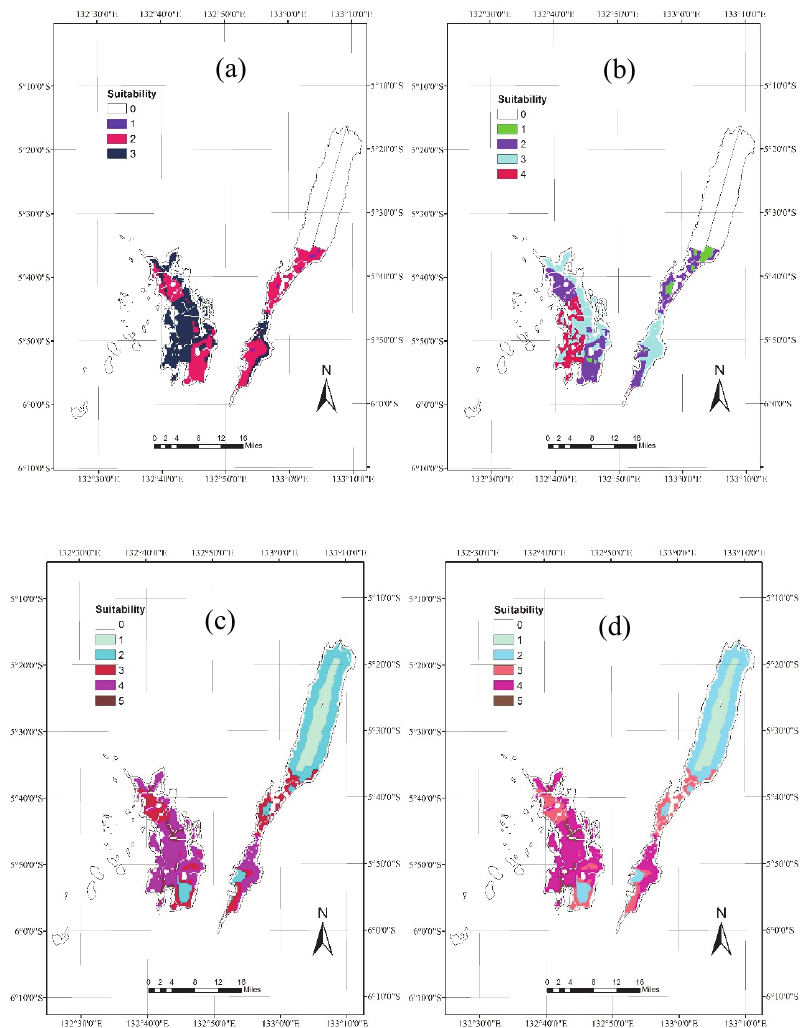
Fig. 8. Sensitivity test: (a) all criterion equal; (b) number of seaweed farmers in each sub-district criteria has half of the weight and other criteria share rest of weight equally; (c) (cid:3399)20% of weight for AHP; (d) (cid:3399)20% of weight for fuzzy